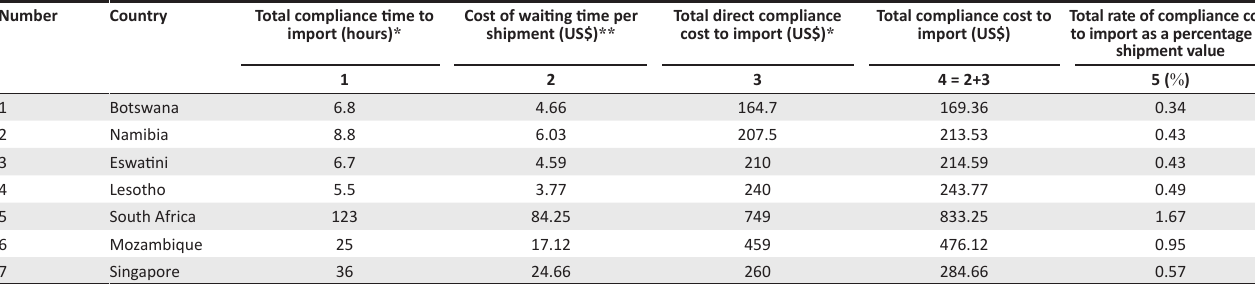
TABLE 2: Total compliance time and cost to import per shipment (2018). Number Country